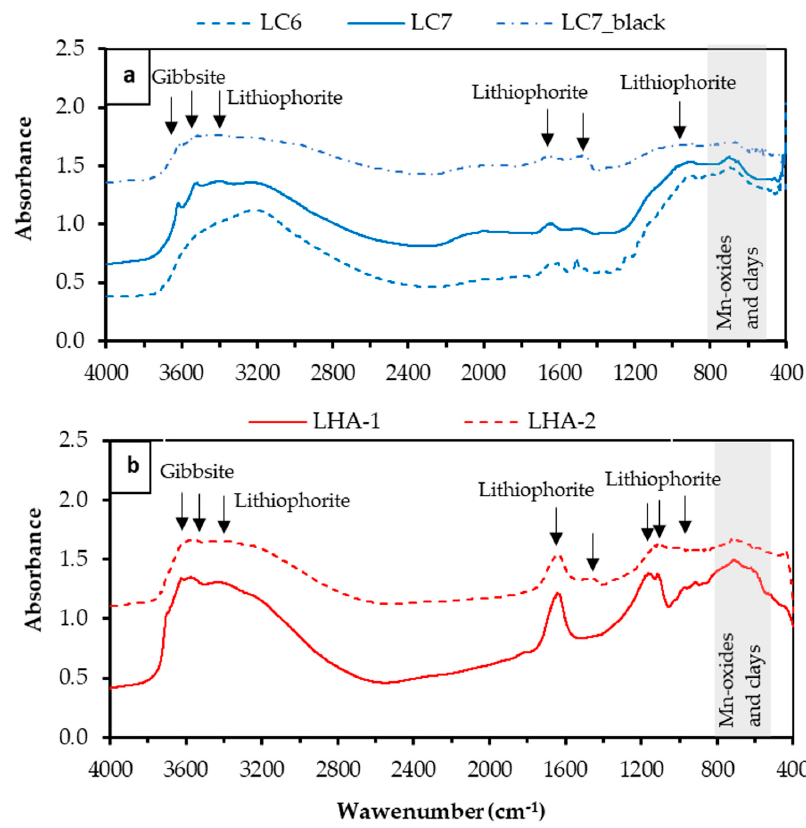
Figure 6. IR spectra of ( a ) samples LC6, LC7 and LC7_black from Loma Caribe (Dominican Republic), and ( b ) samples LHA-1and LHA-2 from Loma de Hierro (Venezuela). Arrows indicate the peak positions. The grey shadowed band represents the peaks associated with Mn-oxides.